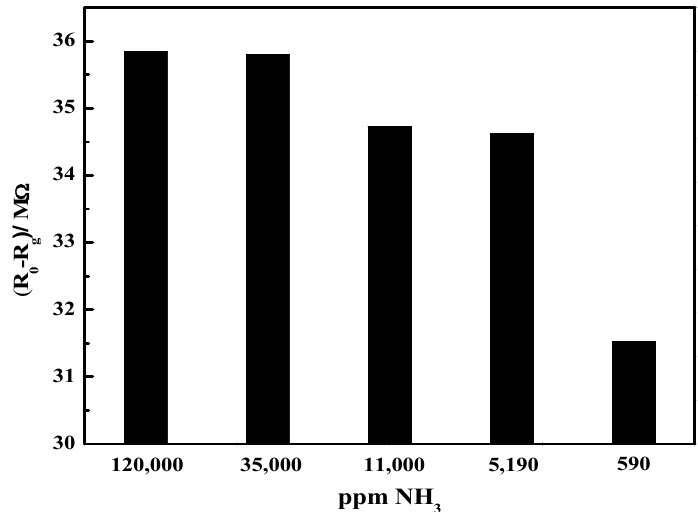
Figure 11. Relative change in the resistance of ZnO thick film on exposure to different levels of ammonia in air at room temperature (23 °C). R resistance in air and ammonia/air mixture, respectively.